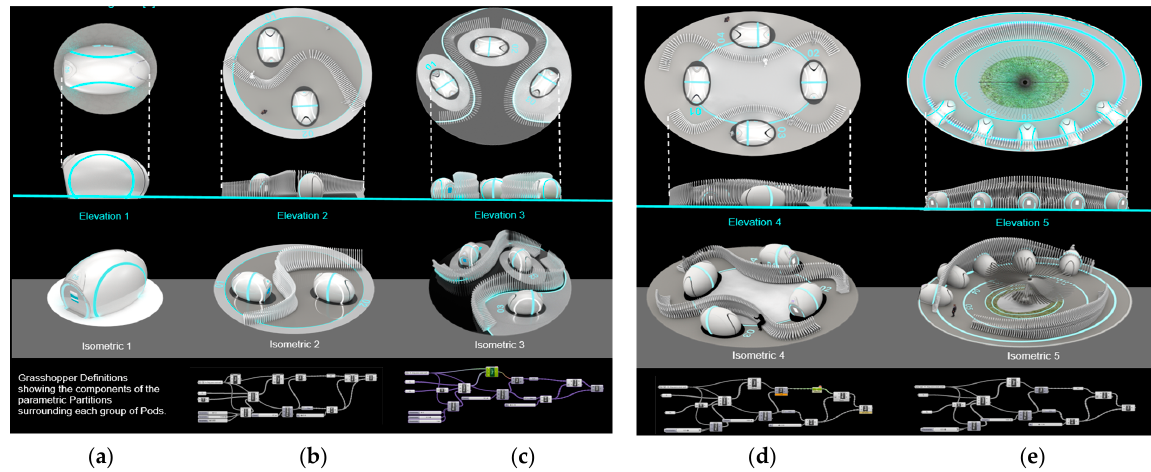
Figure 13. Top views, elevations, and isometrics illustrating different configurations and layouts for the proposed pods: ( a ) single-Reviving-Pod layout; ( b ) two-pod layout; ( c ) three-pod layout illustrating parametric seats and partitions/Grasshopper definitions for each parametric unit; ( d ) four-pod layout; ( e ) five-pod layout showing the wayfinding, landscape design, parametric seats, partitions, and shade (designed by the authors).